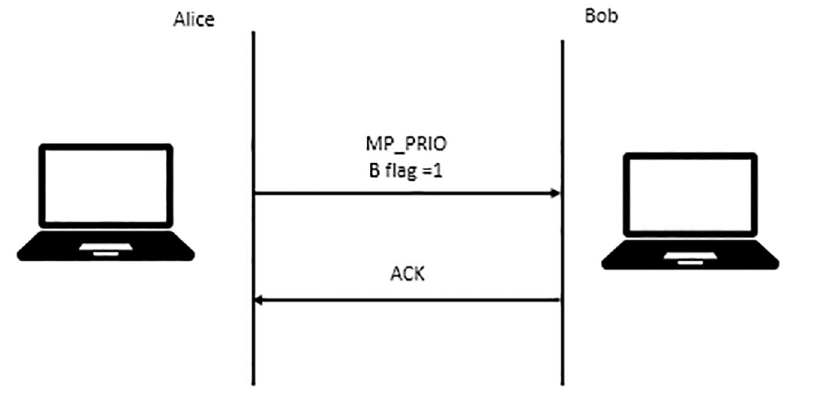
Fig 7. Change in MPTCP subflow’s